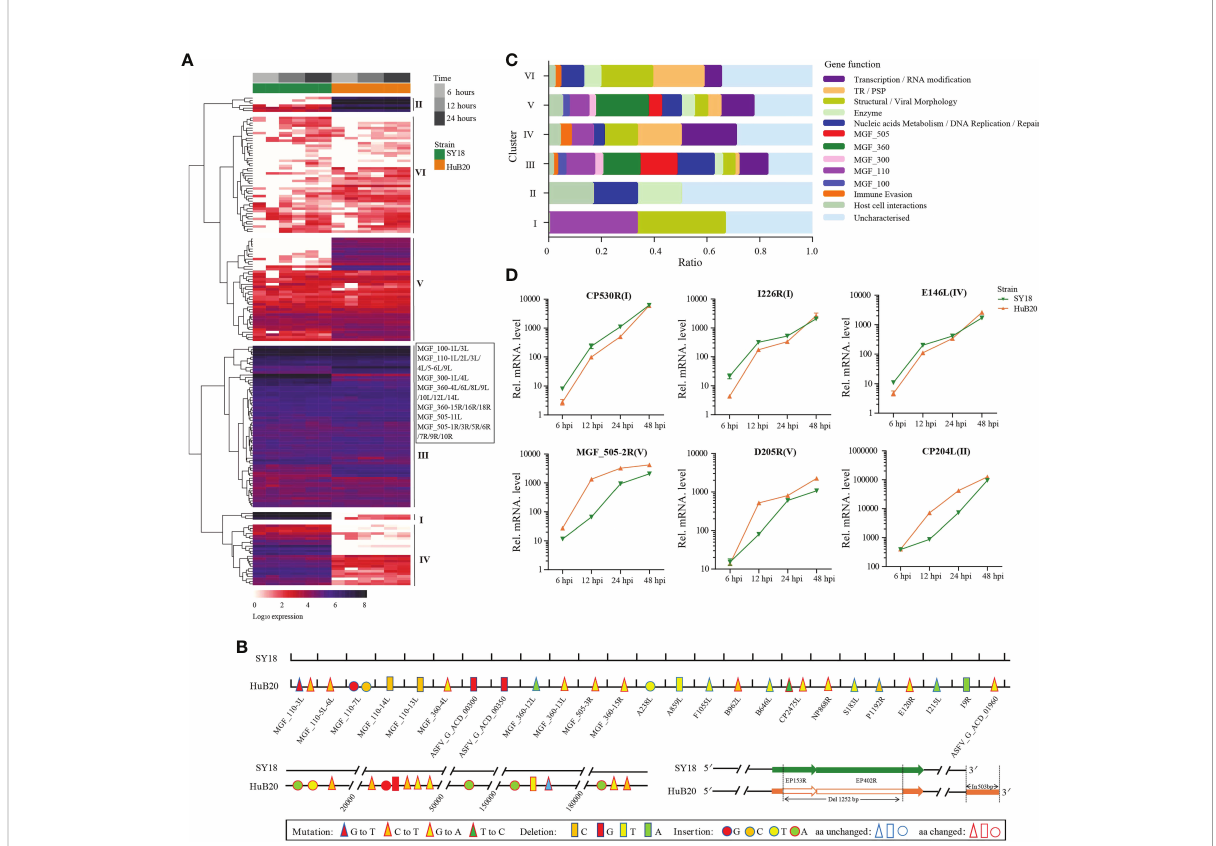
FIGURE 2 Expression analysis and functional classi fi cation of ASFV genes. (A) Heatmap shows the expression levels for the 184 viral genes in the ASFV SY18 and HuB20 strains. (B) Nucleotide mutations, deletions and insertions in ORFs and the noncoding regions between ASFV SY18 and HuB20 genomes. (C) The functional classi fi cation of the detected 184 ASFV genes in SY18 and HuB20 strains, annotated with the most enriched function and divided into 6 clusters. (D) Validation of randomly selected ASFV gene expression by real-time PCR. At 6, 12, 24, and 48 hours after PAMs were infected with ASFV SY18 and HuB20 strain (MOI= 3), the transcriptional level of CP530R, I226R, E146L (highly expressed in the SY18 strain infected group) and MGF_505-2-R, D205R, CP204L (highly expressed in the HuB20 strain infected group) were detected by RT-qPCR. The fold-difference was measured by the 2 - DD Ct method. The RNA levels were normalized to the corresponding b